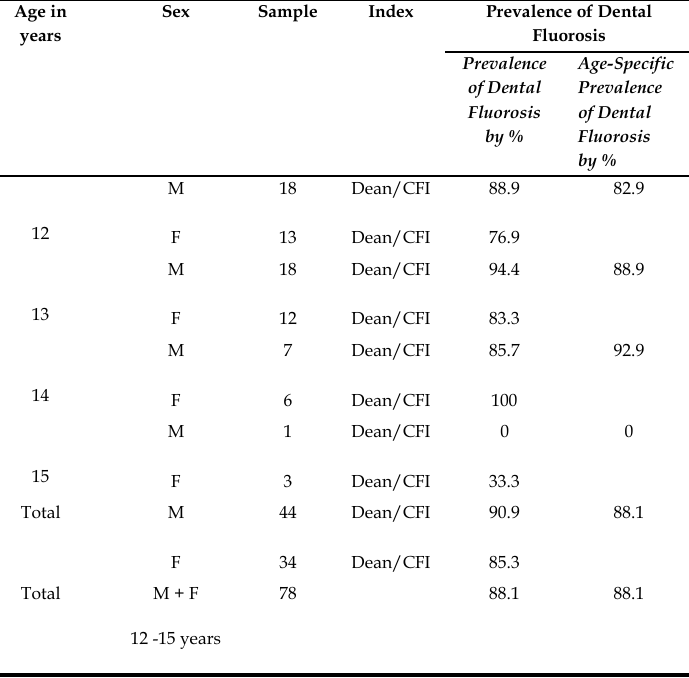
Table 3: Prevalence and Community Fluorosis Index of the Semi-Urban Studied